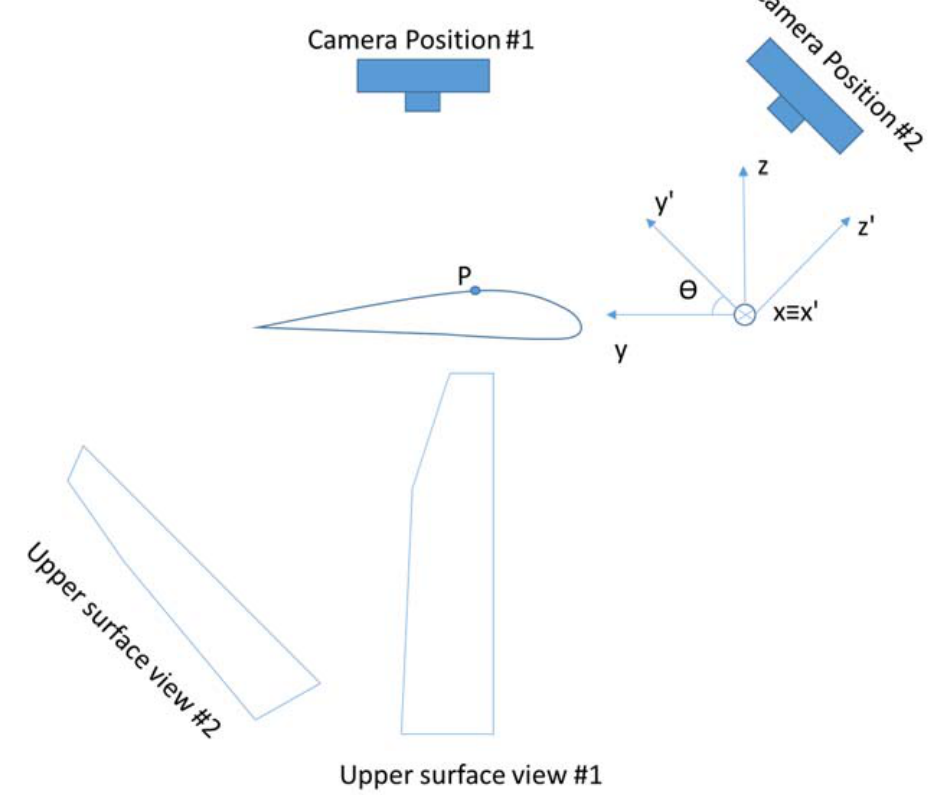
Figure 6. Camera positions, views, and reference frames for determination of coordinates of wing surface points.